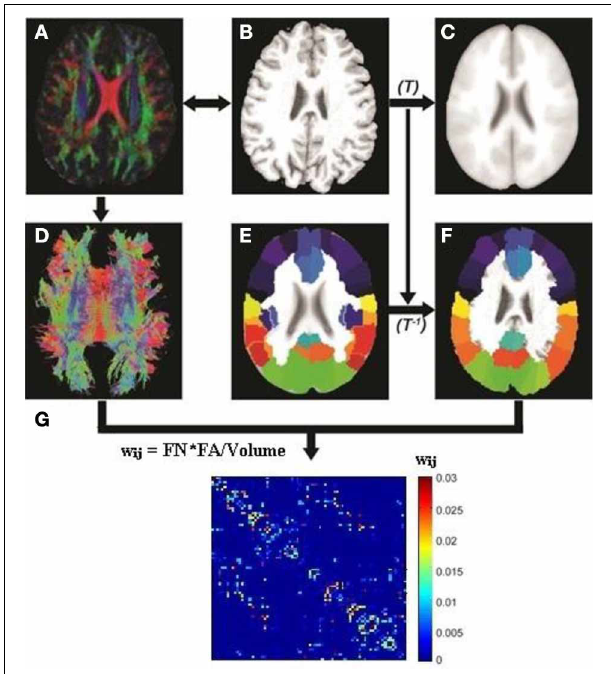
FIGURE 1 | Flowchart for the construction of the DTI white matter (WM) network for each subject. The T 1 -weighted image of each subject (B) was first coregistered into DTI native space (A) using rigid transformation to the b0 image (not shown). The resultant T1 image was then non-linearly registered to the ICBM 152 template (C) in the MNI space to obtain transformation matrix T . The AAL template (E) was then inversely warped back to the individual DTI space (F) using the inverse transformation ( T − 1 ). Whole brain white matter fibers were reconstructed using a deterministic tractography method in native DTI space (D) . The WM fibers connecting any pair of regions were located and the edge weight between the two regions was calculated from the FA, fiber number (FN) and average volume of the two cortical regions. (G) A sample white matter network for one